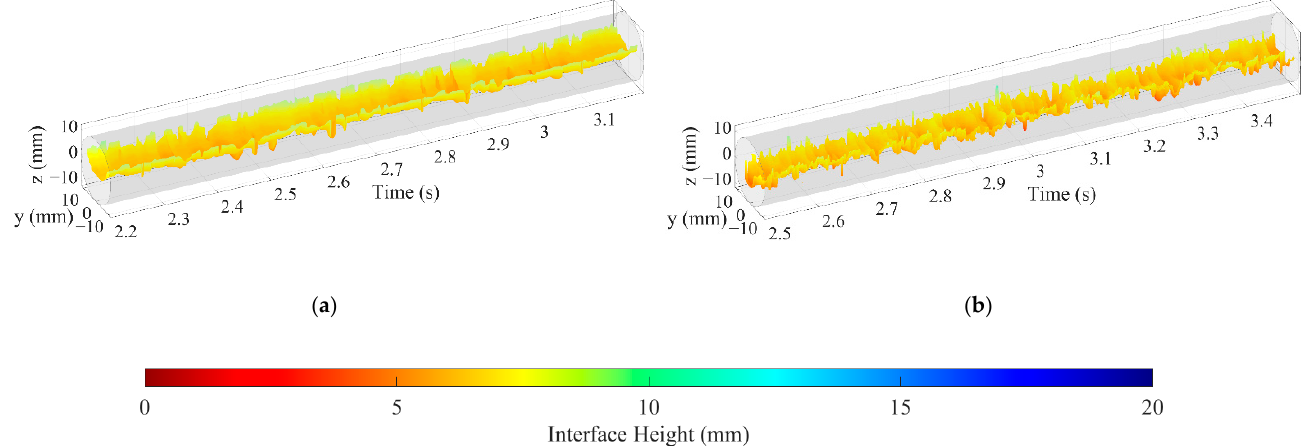
Figure 17. Oil–water interfaces extracted under typical oil–water flow conditions (0°): ( a ) U sw = 0.368 m/s, U so = 0.236 m/s, ST&MI; ( b ) U sw = 0.737 m/s, U so = 0.552 m/s, D W/O&D O/W.